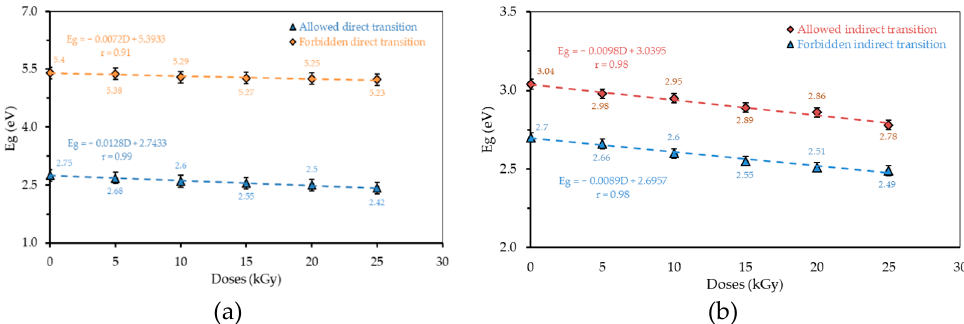
Figure 6. The relationship between the radiation dose and Eg for each transition of H 3 PO 4 75 v%: (a) direct transition; and (b) indirect transition.